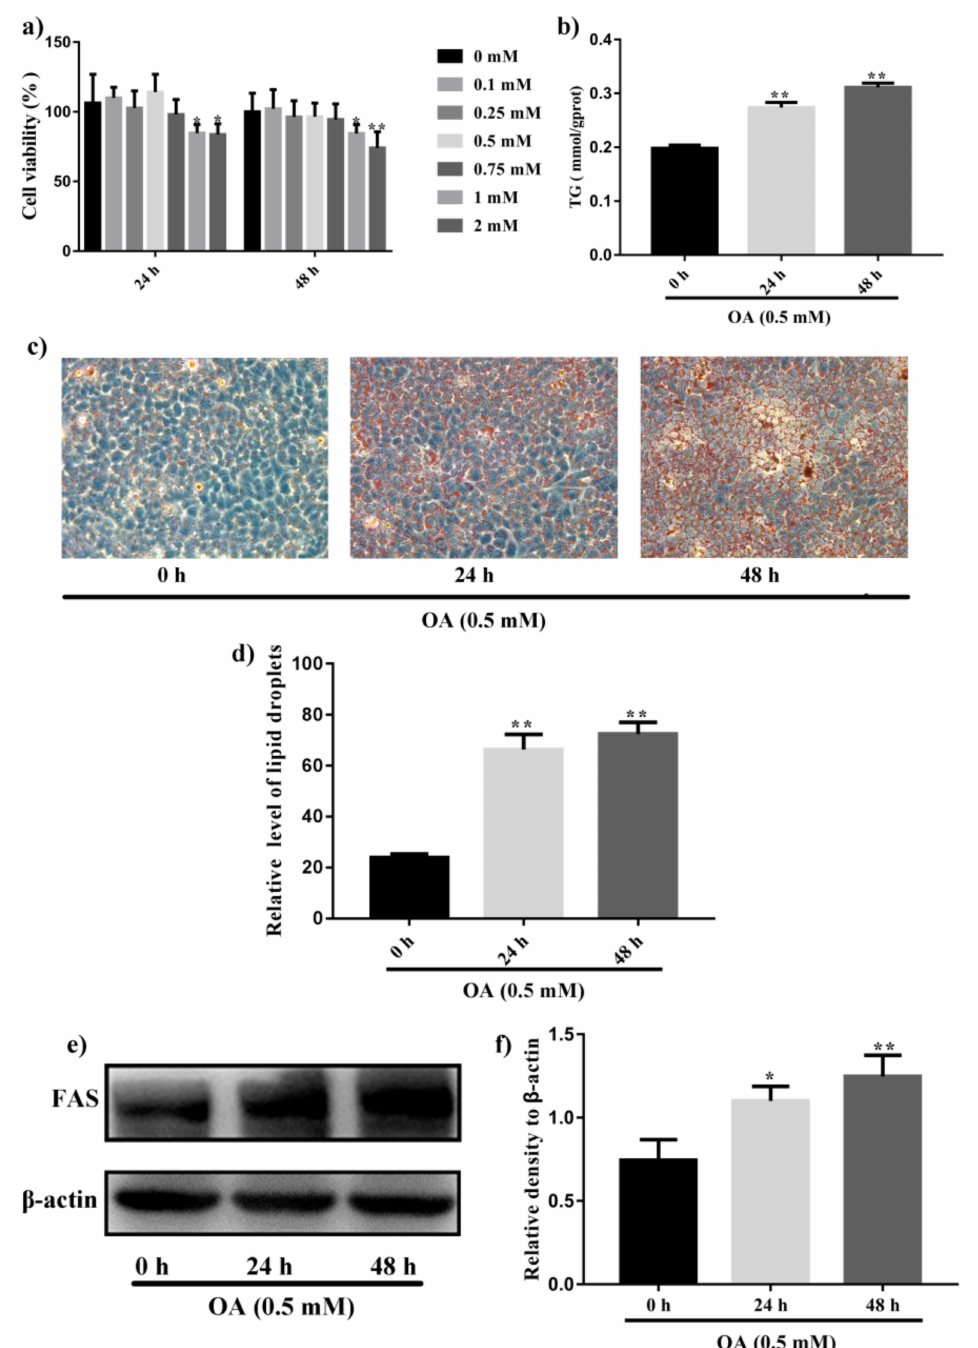
Figure 1. Induction of steatosis by OA in HepG2 cells. ( a ) SRB assay of cell viability of HepG2 cells treated with different concentration of OA for 24 h and 48 h. ( b ) Measurement of intracellular TG contents in HepG2 cells after incubation with 0.5 mM OA for 24 h and 48 h. ( c ) Oil red O staining to detect intracellular lipid droplets in HepG2 cells after treatment with 0.5 mM OA for 24 h and 48 h. ( d ) Quantitative analysis of intracellular lipid droplets accumulation in HepG2 cells. ( e ) Western blot analysis of expression of FAS in HepG2 cells after treatment with 0.5 mM OA for 24 h and 48 h. ( f ) Quantification results of the expression of FAS. Data were expressed as Mean ± SD of three independent experiments ( n = 3). * p < 0.05 and ** p < 0.01, compared with HepG2 cells without OA treatment (0